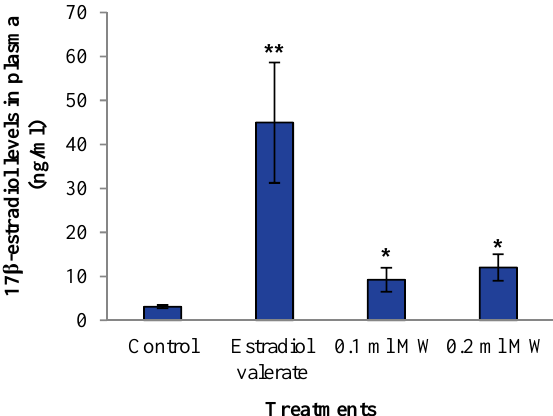
Figure 1. Plasma 17 β -estradiol levels in immature common carp treated with estradiol valerate and different concentrations of municipal wastewater for 21 days (mean ± SD) (n = 9) Asterisk (*) indicates that the di ff erence between the experimental and control groups was significant at P < 0.05